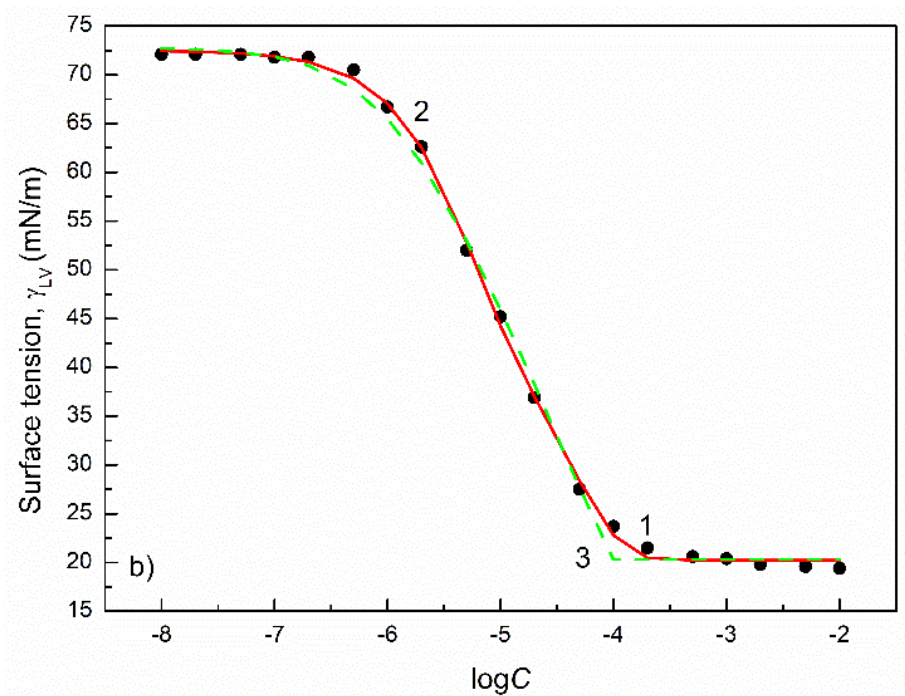
Figure 4. A plot of the surface tension ( γ LV ) of the aqueous solutions of FC1 ( a ) and FC2 ( b ) vs. the logarithm of their concentration ( logC ). Points 1 correspond to the measured values [30], curves 2 and 3 correspond to the values calculated from the exponential function of the second order (Equation (2)) and Szyszkowski equation (Equation (3)), respectively.